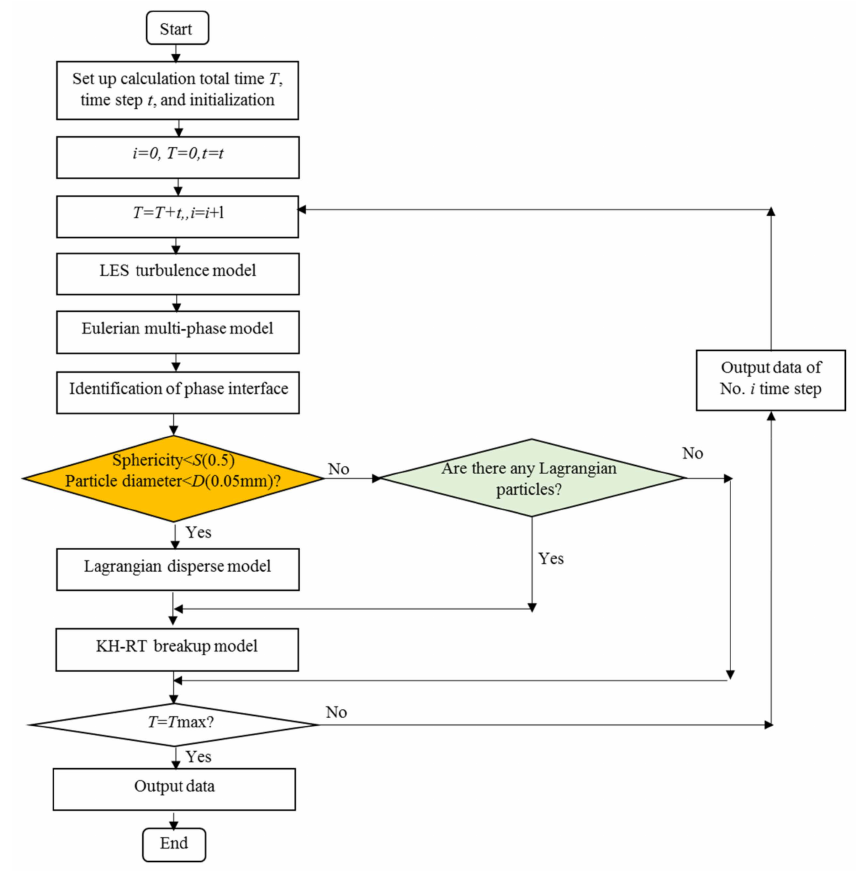
Figure 2. Simulation procedure of SD-ELSA